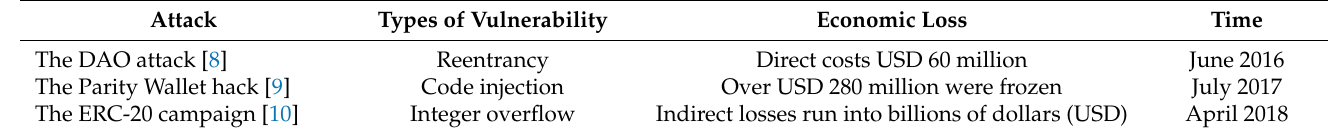
Table 1. Attacks on smart